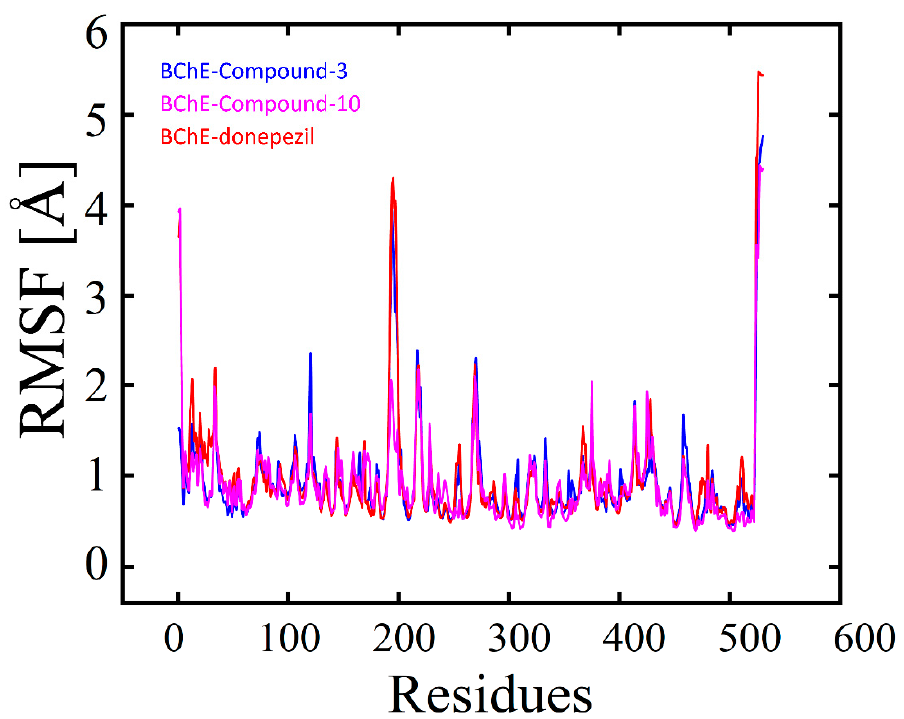
Figure 6. RMSF plot of compound 3 (blue color), compound 10 (magenta color), and donepezil (red color) in complex with BuChE. Table 2. MMGBSA analysis. All units are reported in